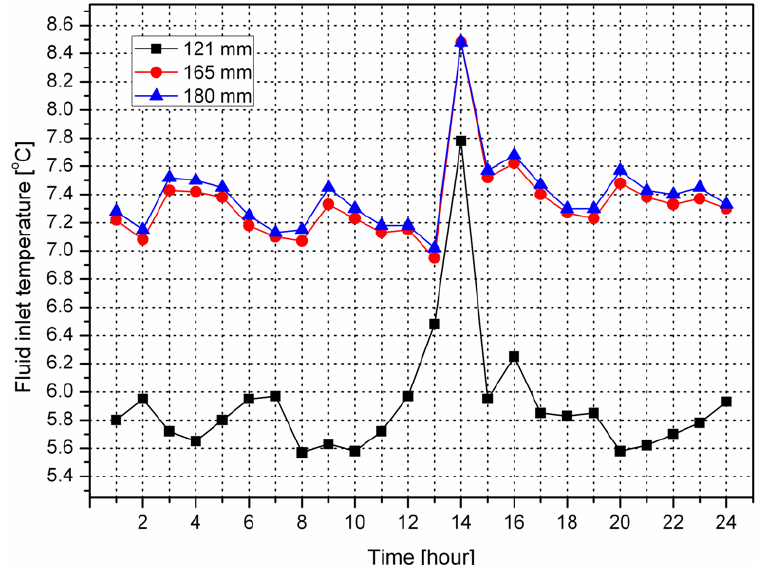
Figure 10. Hourly fluid-inlet temperature distribution of the three investigated BHEs at December 27,